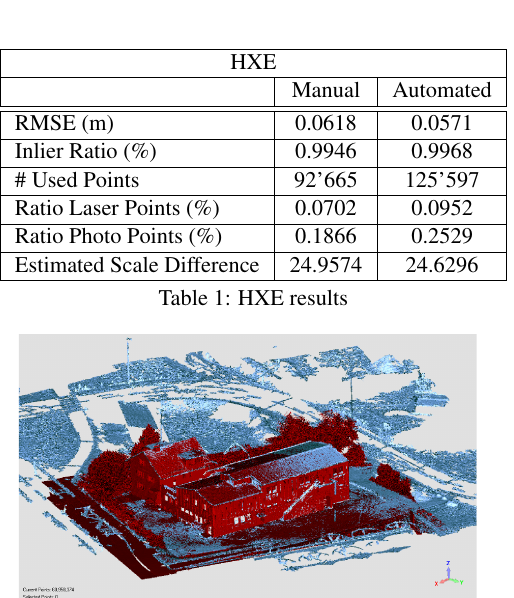
Figure 11: HXE automatically registered, Red/Dark: Laser, Blue/Light: Photogrammetry